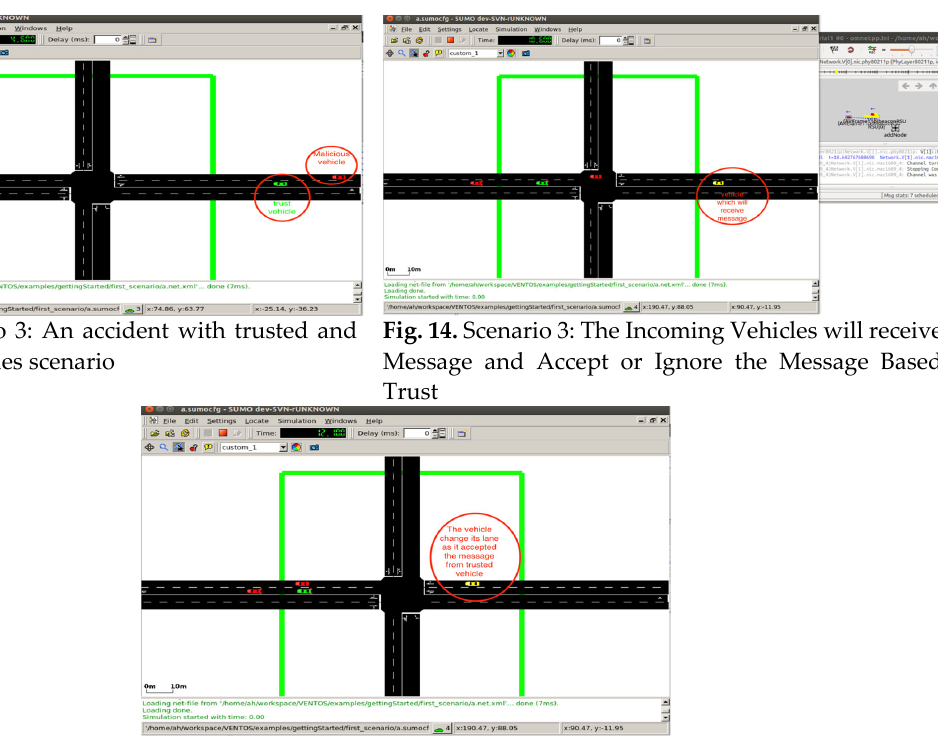
Fig. 15. Scenario 3: Yellow Vehicle Accepts the Message and Change the Lane